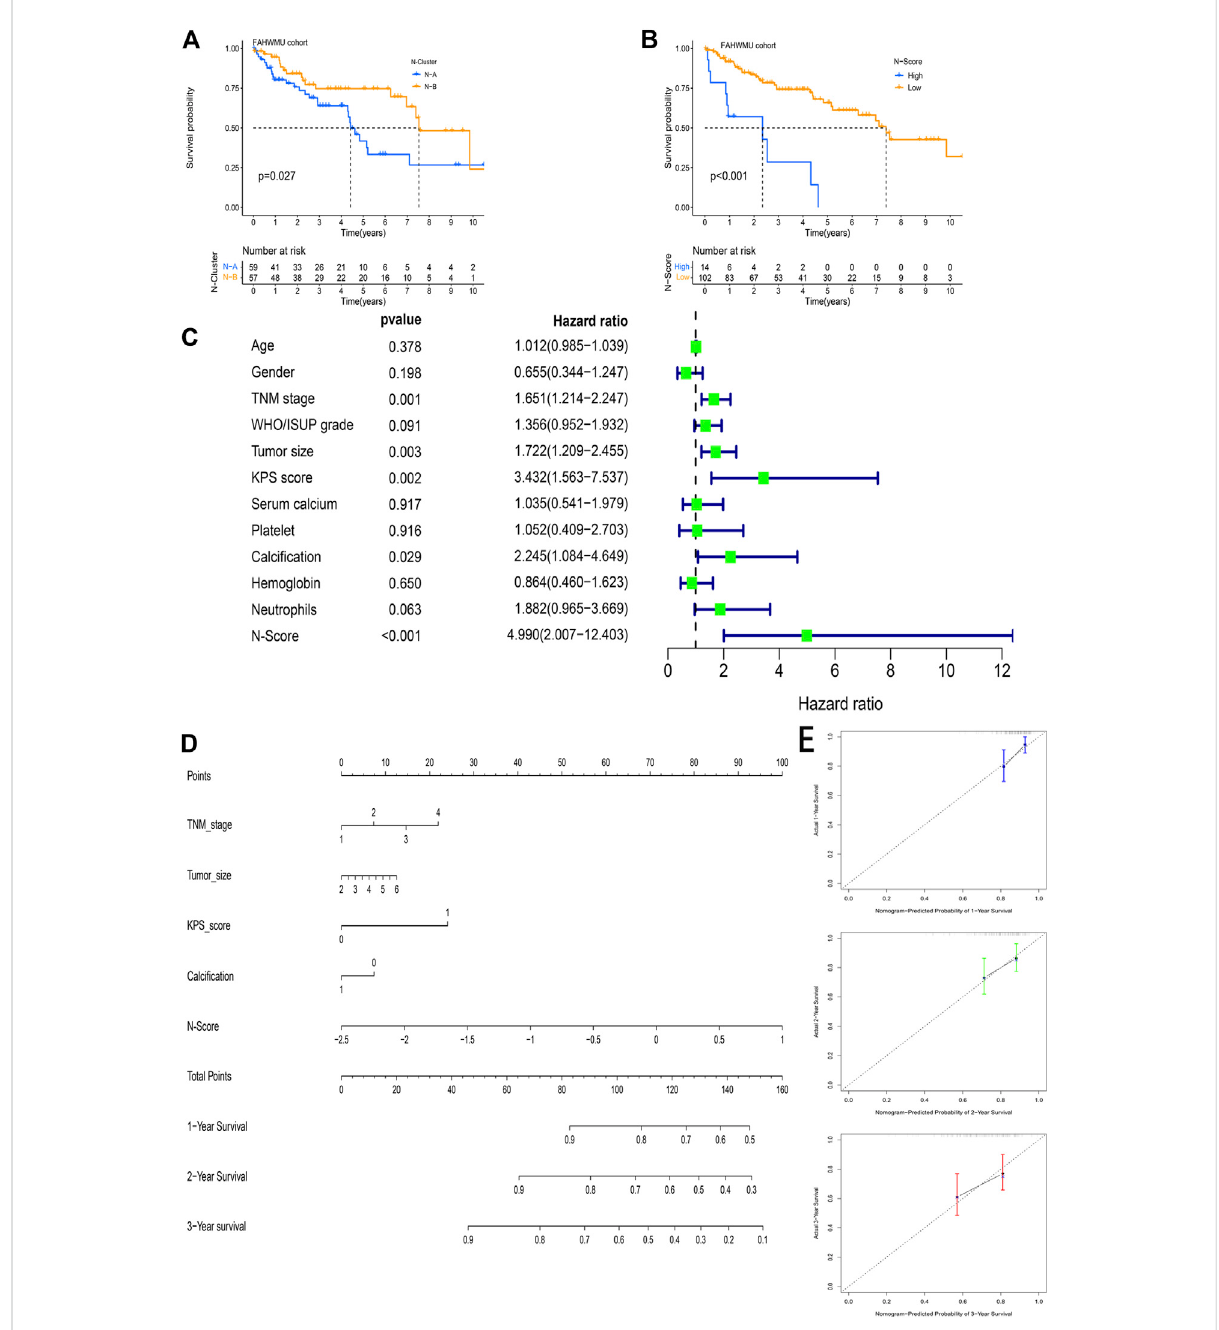
FIGURE 8 The external clinical value of the N-Score. (A) Kaplan-Meier (K-M) survival curve shows that the effect of N-Clusters on overall survival (OS) in the FAHWMU cohort ( p < 0.027). (B) Kaplan-Meier (K-M) survival curve shows that the effect of N-Scores on overall survival (OS) in the FAHWMU cohort( p < 0.001). (C) TheunivariateCoxanalysisofN-Scoreandclinicalcharacteristics(Age,Gender.TNMstage,WHO/ISUPgrade,Tumorsize,KPS score, Serum calcium, Platelet, Calci fi cation, Hemoglobin, and Neutrophils). (D) The nomogram combining TNM stage, Tumor size, Calci fi cation, and N-Score. (E) The calibrate curve on the 1st, 2nd, and 3rd